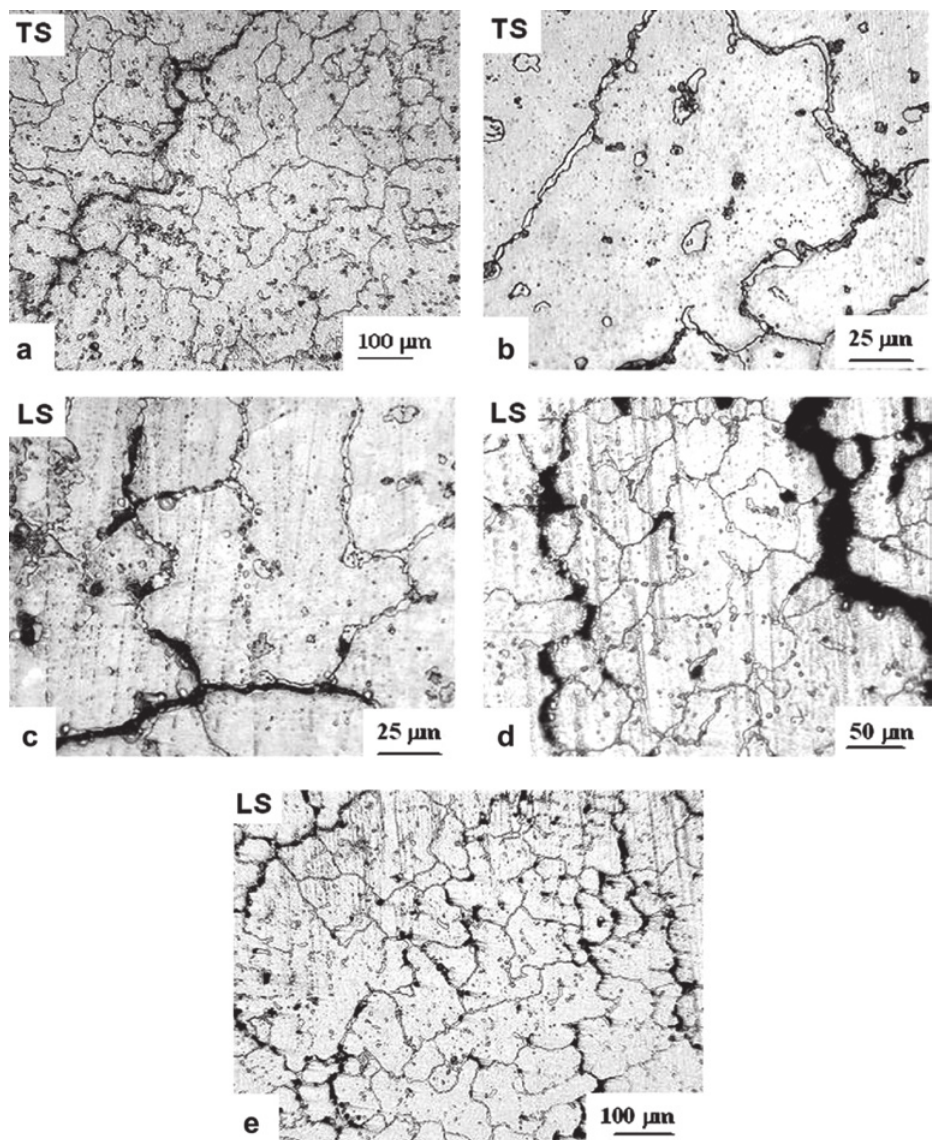
Fig. 11: Photomicrographs of etched specimens from failed tube portion. Interdendritic cracks with carbide phases halved at many places. Creep voids have been found only on outer wall side. TS = transverse section, LS = longitudinal section